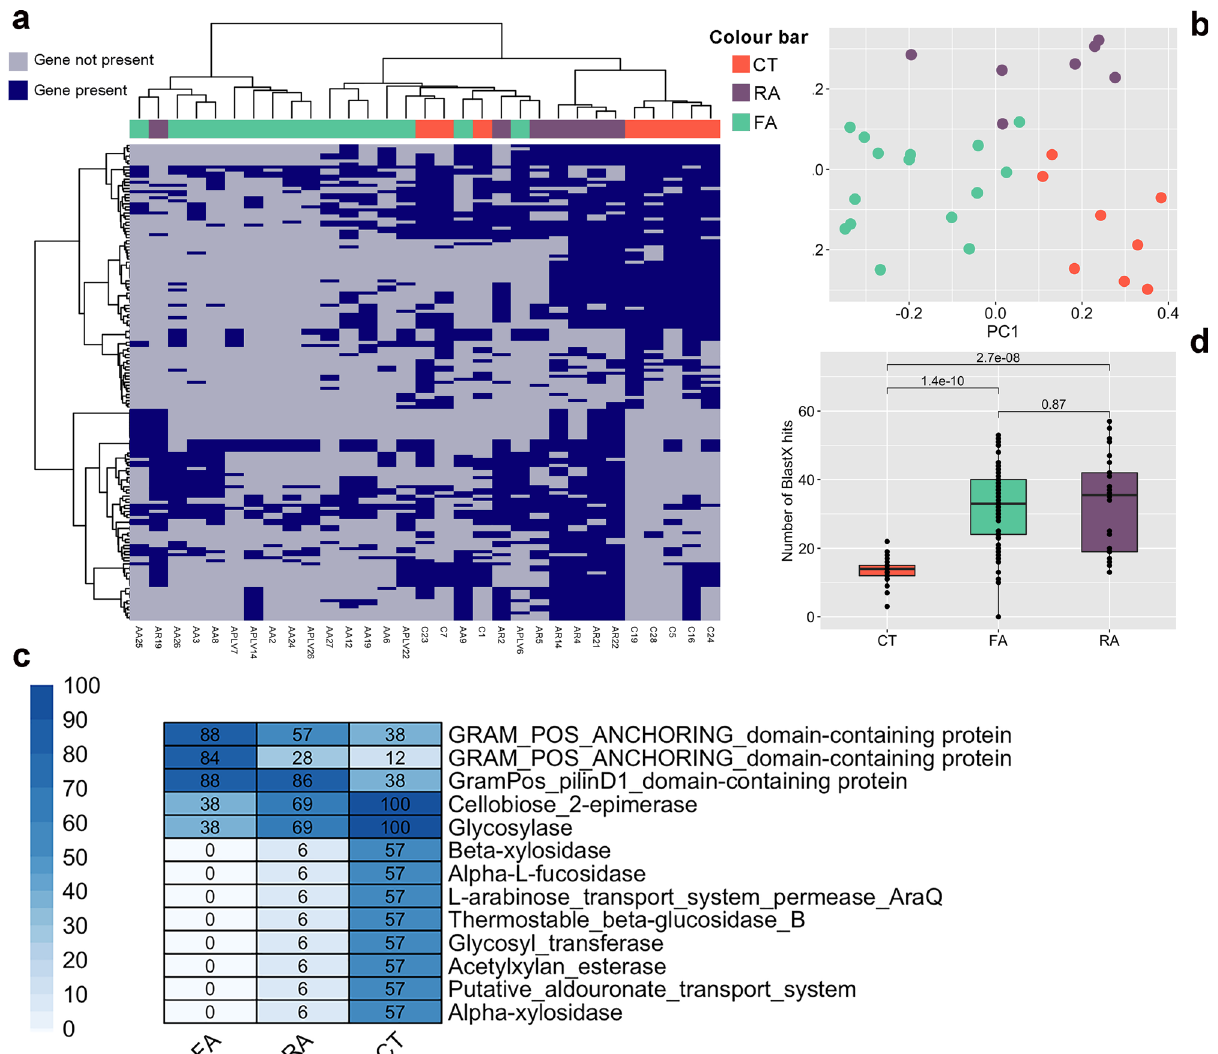
Fig. 5 Allergic children harbor a different R. gnavus pangenome. a Presence and absence of 155 R. gnavus genes signi fi cantly different between healthy (CT), food (FA) and respiratory (RA) allergic children (blue, present; gray, absent). The signi fi cance was tested by applying paired chi-squared tests. b Principal coordinates analysis based on presence/absence of the 155 signi fi cant genes. c Heatplot showing the prevalence (%) of selected signi fi cant genes in the three children groups (CT, healthy controls; FA, food allergy; RA, respiratory allergy). The complete list of the 155 signi fi cant genes and their prevalence is reported in Supplementary Data 2. d Box plots showing the number of hits (> 90% identity over 50% of query length) against R. gnavus genes involved in the production of a pro-in fl ammatory polysaccharide. Boxes represent the interquartile range (IQR) between the fi rst and third quartiles, and the line inside represents the median (2nd quartile). Whiskers denote the lowest and the highest values within 1.5 x IQR from the fi rst and third quartiles, respectively. The signi fi cance was tested by applying pairwise Wilcoxon test. Data are obtained from n = 29, 55, and 30 biologically independent samples for CT (healthy controls), FA (food allergy) and RA (respiratory allergy),